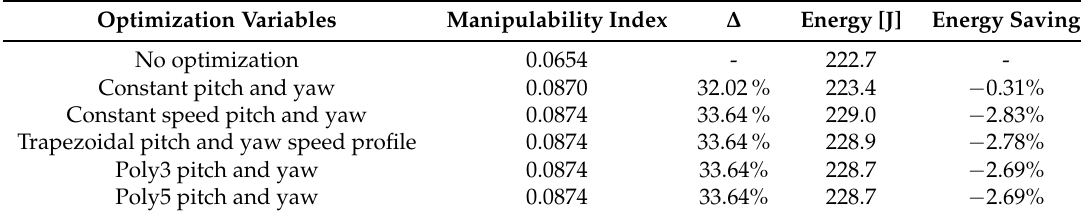
Table 8. Manipulability maximization: test-case II, motion along a vertical